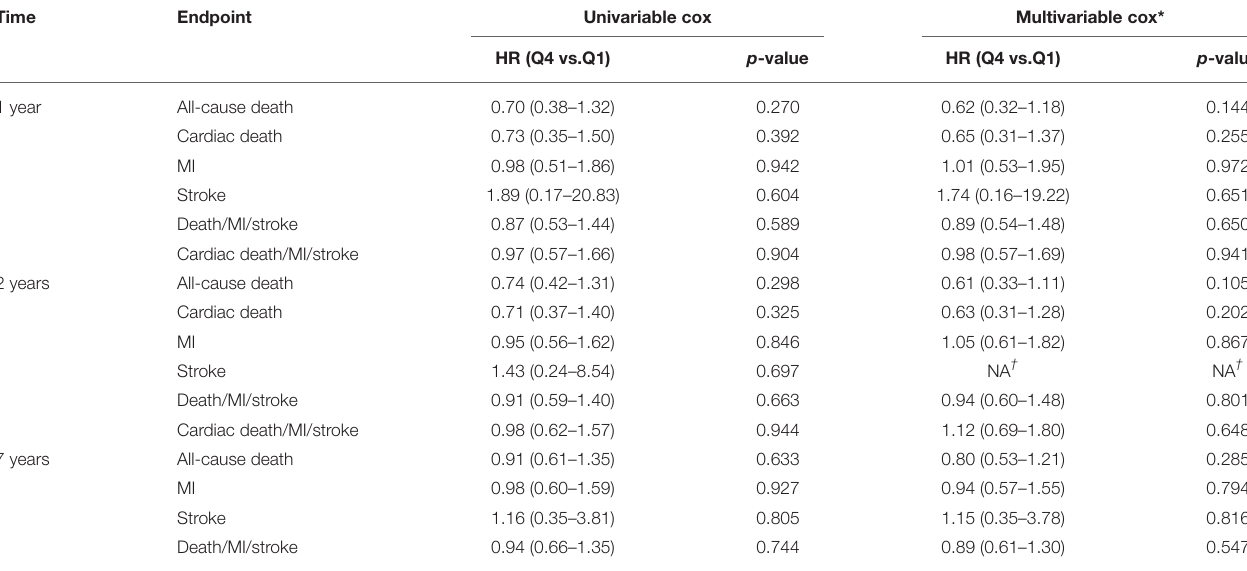
TABLE 4 | Association between Podocan and all endpoints in the TnT positive subpopulation.